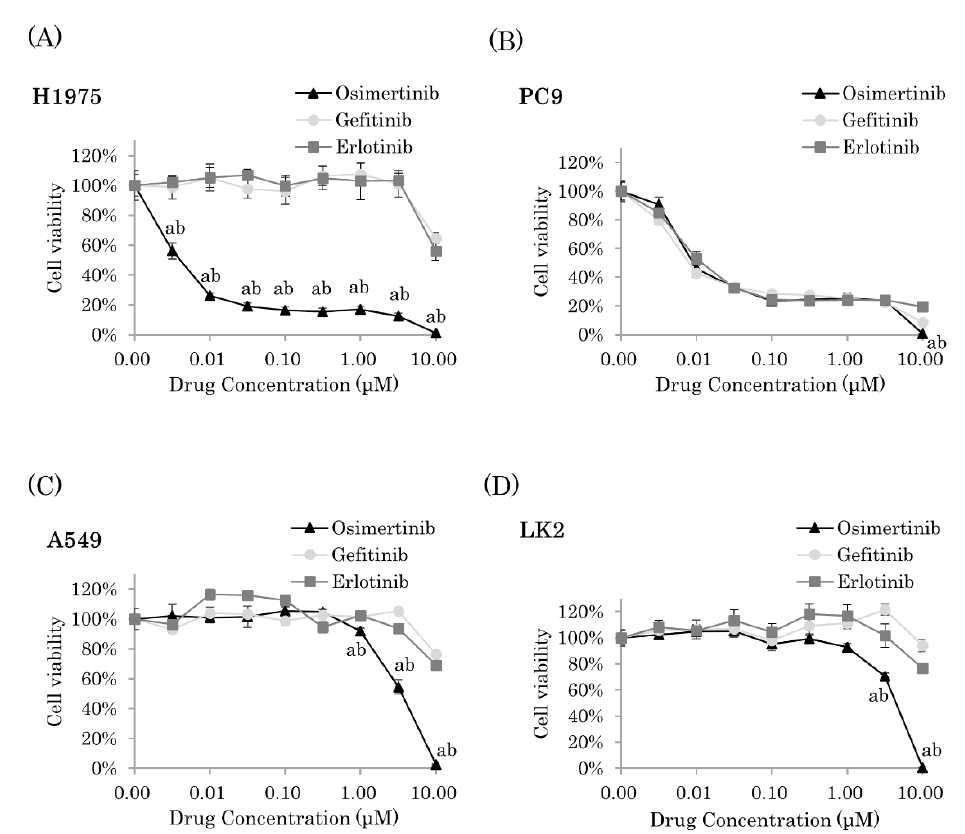
Figure 1. The inhibitory effects of EGFR-TKIs on NSCLC cell proliferation. NSCLC cell lines (( A ), H1975; ( B ), PC9; ( C ), A549; and ( D ), LK2) were treated with erlotinib, gefitinib, and osimertinib for 72 h at various concentrations ( n = 6). The results were expressed as mean ± standard deviation. a: Osimertinib vs. Gefitinib, p < 0.05. b: Osimertinib vs. Erlotinib, p < 0.05.